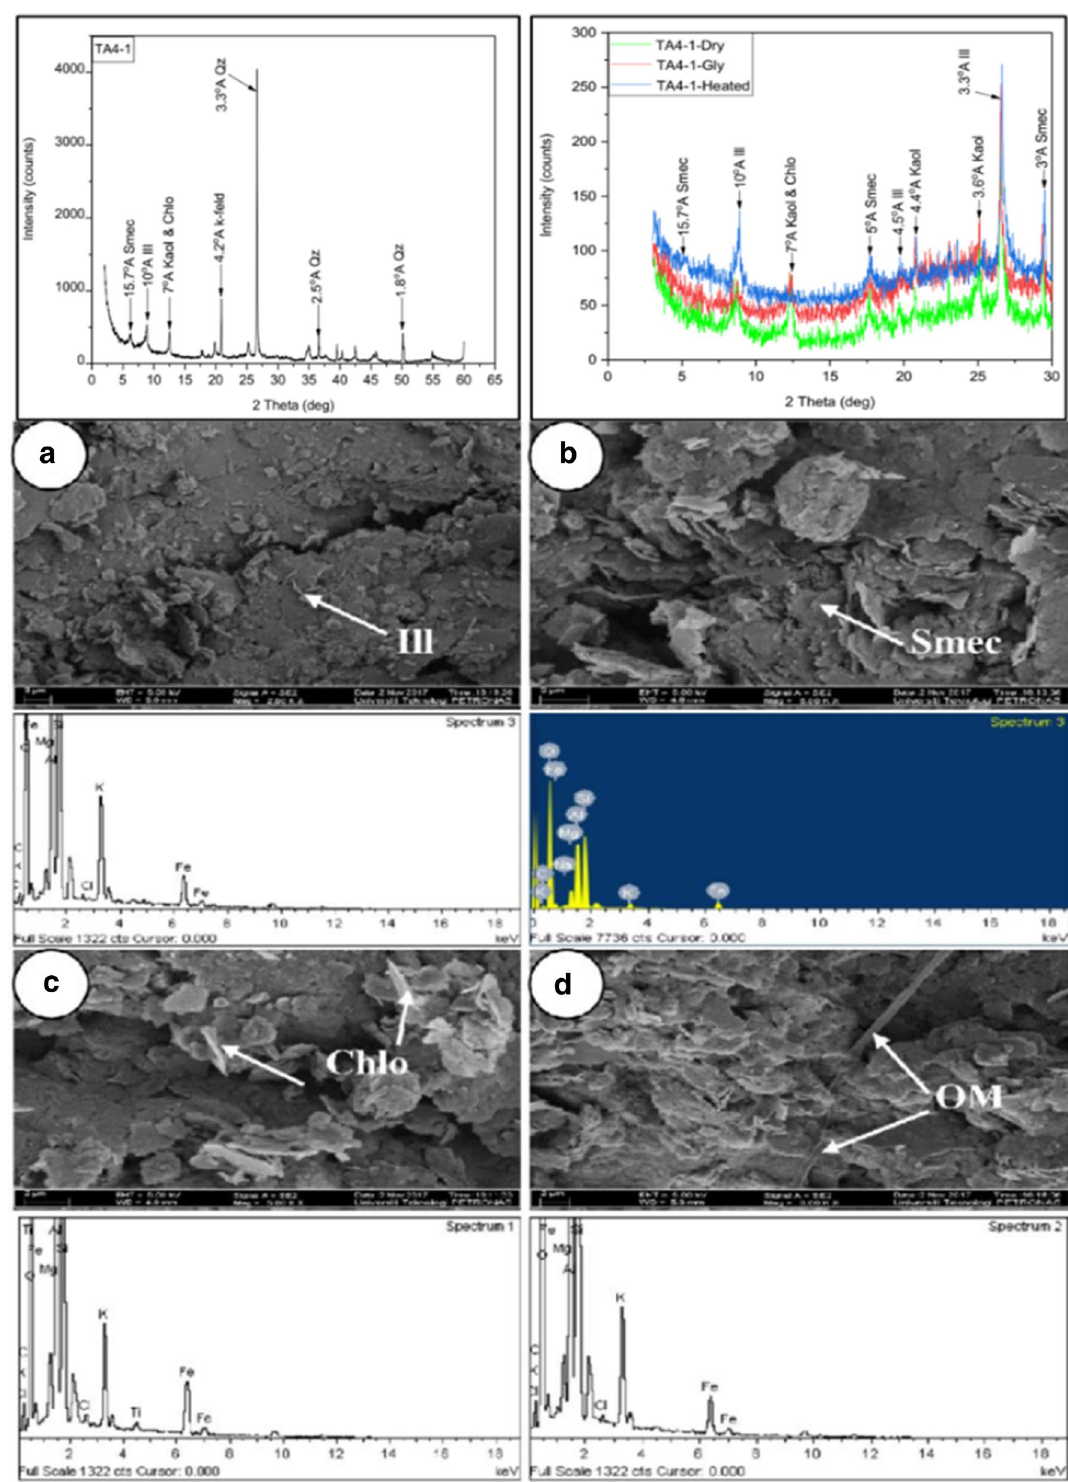
Fig. 4 XRD, XRD clay separation and FESEM micrograph for Tatau Formation showing the main mineral components in the shale and mudstone samples and their energy-dispersive X-ray (EDX) spec-